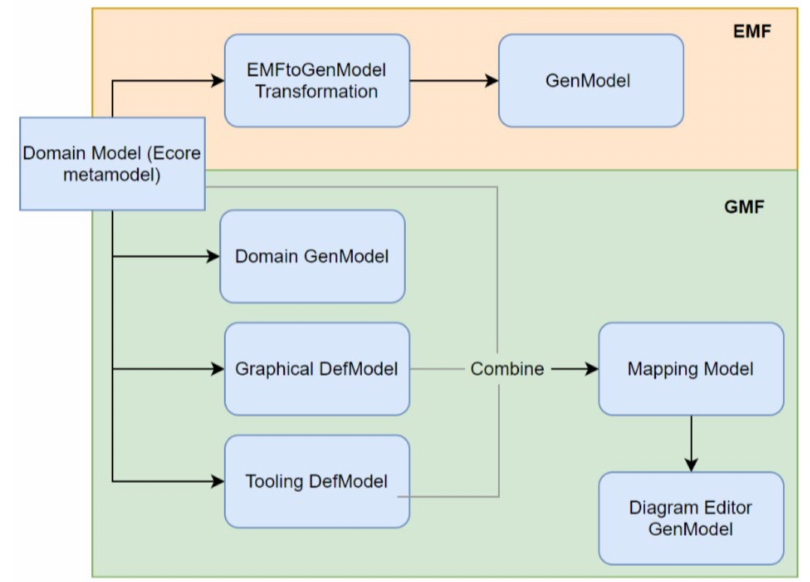
Figure 1. EMF/GMF model transformation